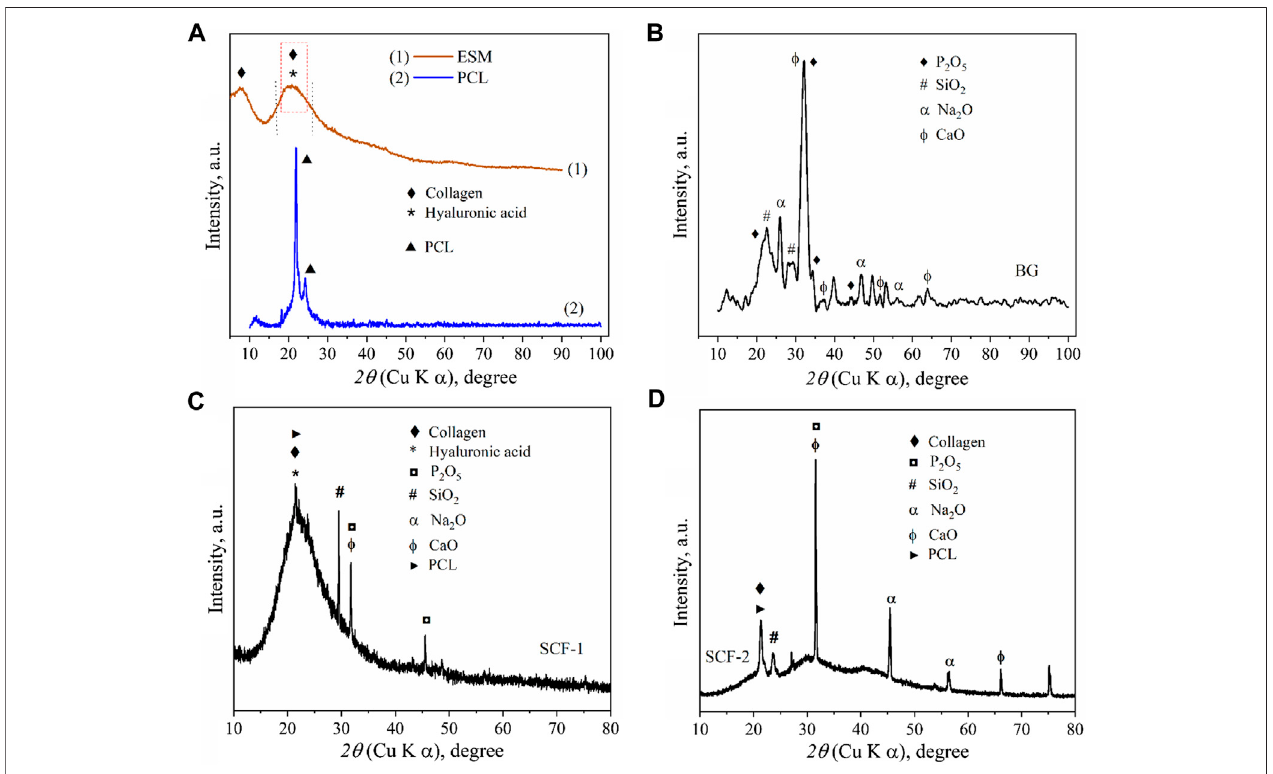
FIGURE 1 | XRD patterns of: eggshell membranes conformed by collagen and hyaluronic acid and polycaprolactone (A) , Bioactive glass (B) , SCF-1 scaffold (C) , and SCF-2 scaffold (D) .